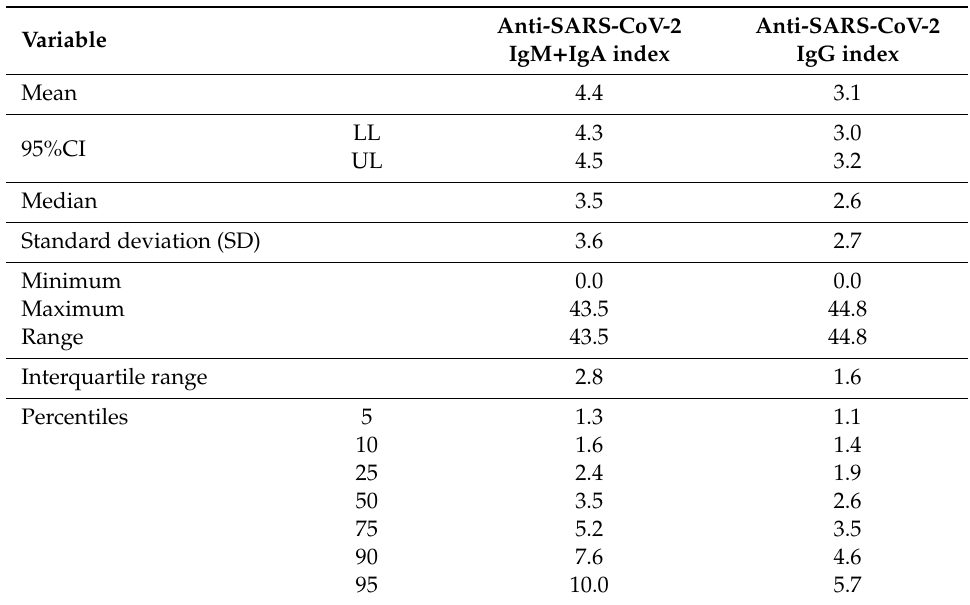
Table 1. Anti-SARS-CoV-2 IgM + IgA and IgG indexes in a group of 5082 police employees